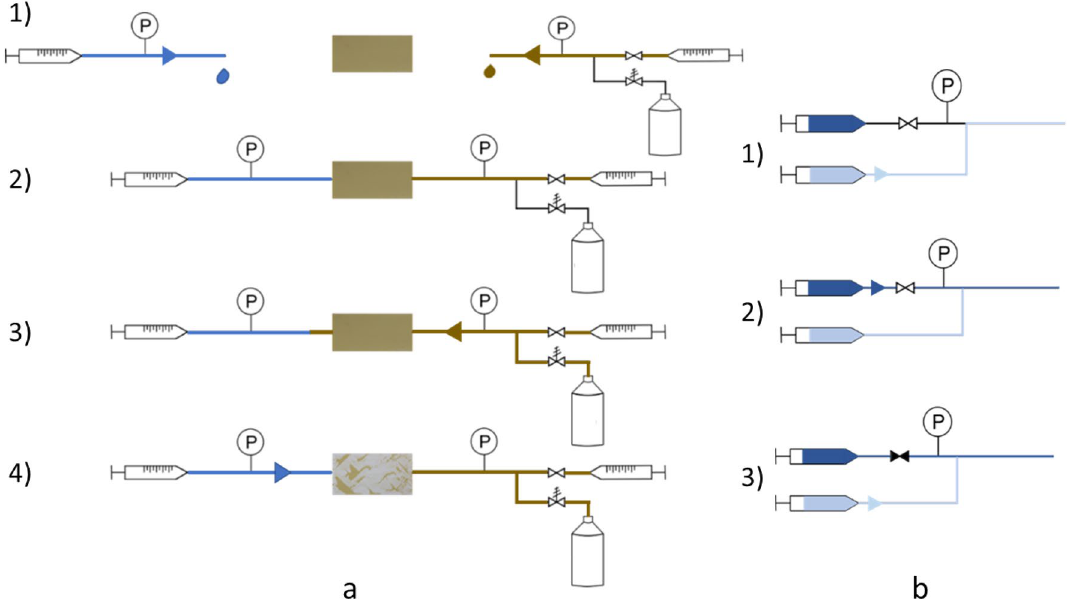
Figure 9. ( a ) 1-step recovery test procedure: 1) Filling the inlet and outlet lines with HS-Na and crude oil, respectively; 2) connecting the tubes and the oil-saturated chip; 3) pumping oil at 2 µl/min; 4) pumping water initially at 2 µl/min and later at 0.5 µl/min. ( b ) Procedure for filling the water line in 2-step recovery test: 1) flow the second flood; 2) flow the high salinity brine; 3) shut the valve on the high salinity brine line and use the second flood syringe for injection after connecting to the